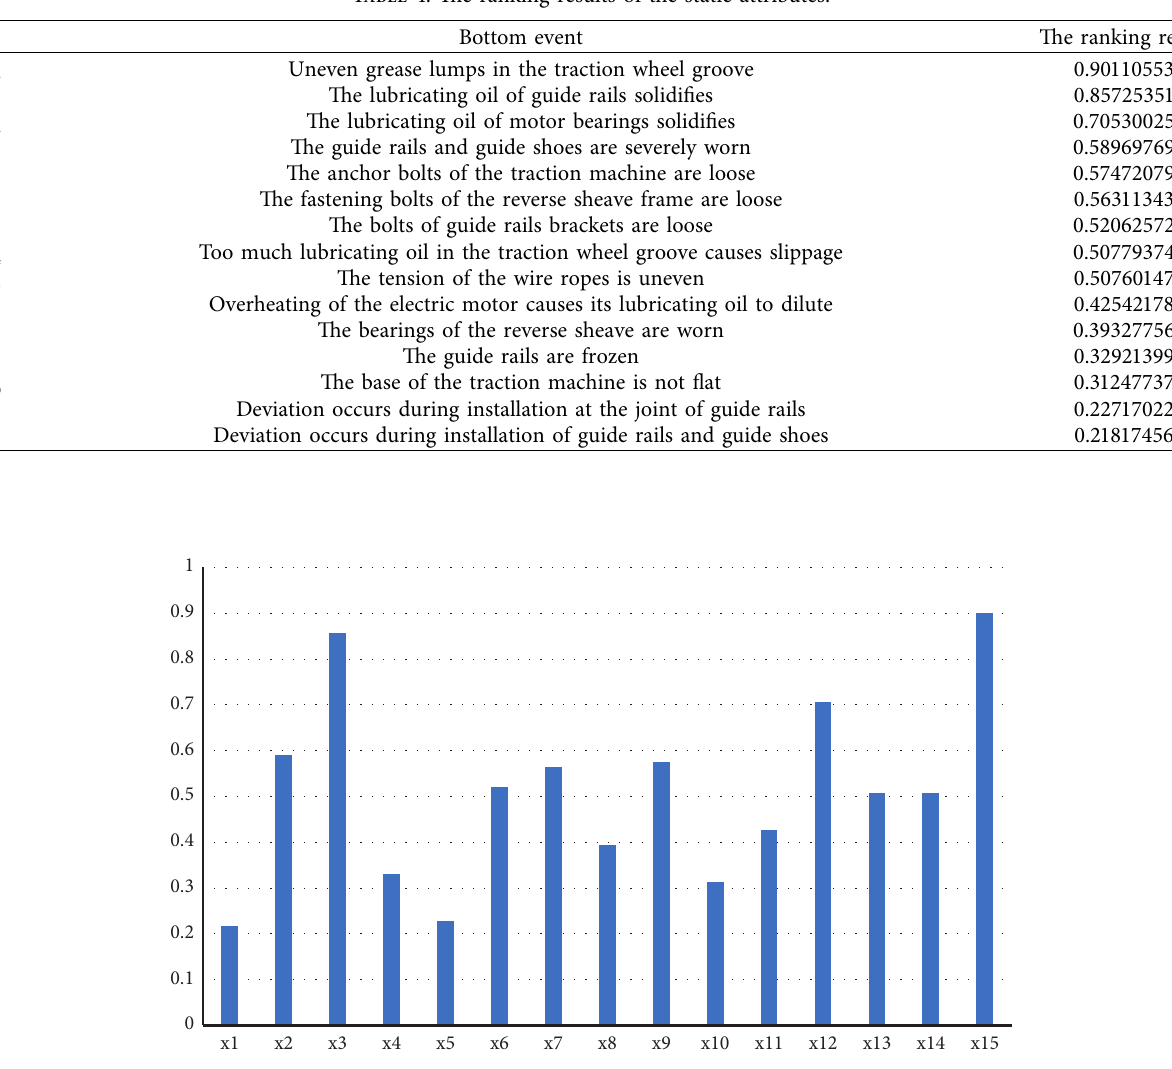
Figure 4: The score of the static Table 4: The ranking results of the static attributes.